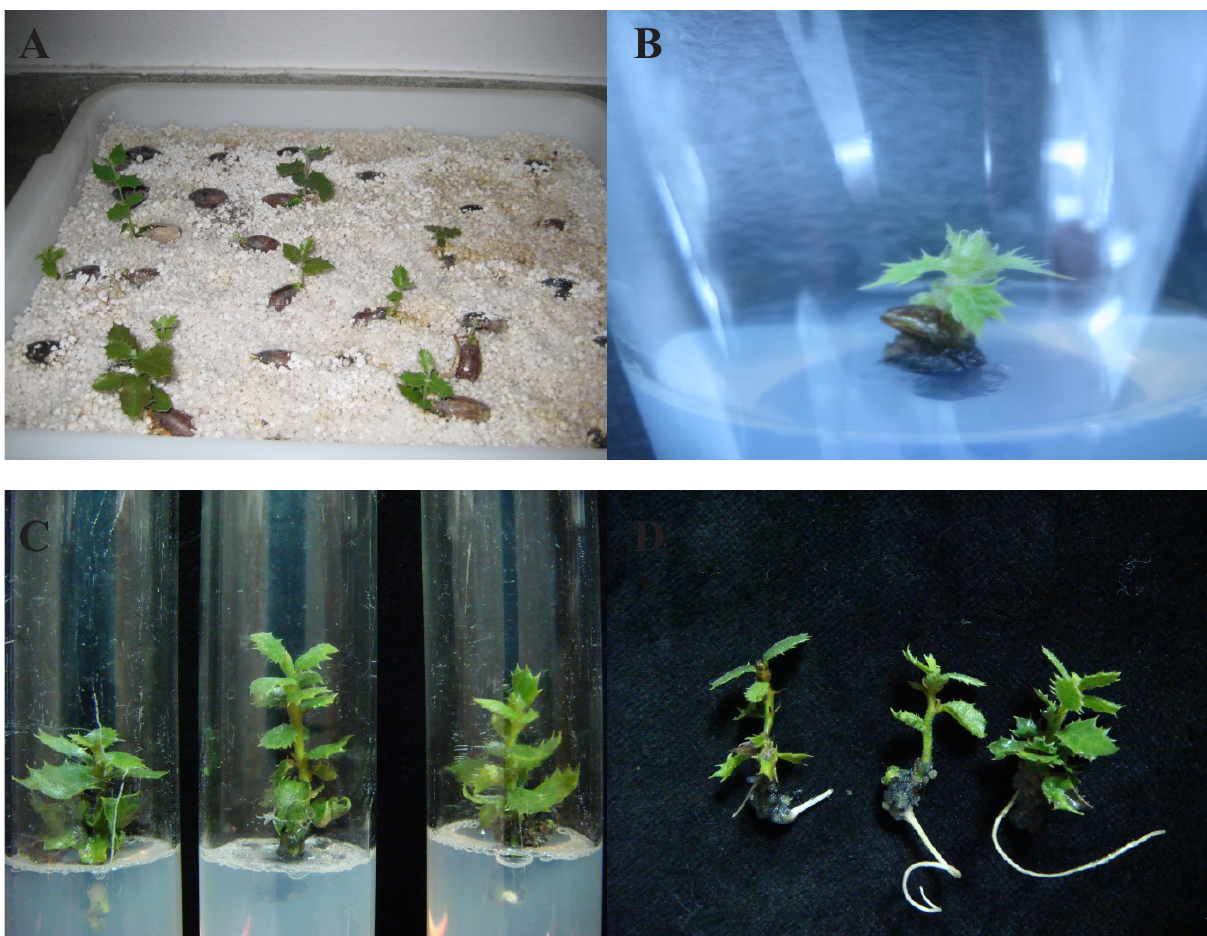
Figure 1. In vitro propagation by axillary shoot proliferation of Quercus ilex . A: Acorns germinated in the growth chamber. B: Shoot development from nodal explants taken from a shoot obtained after acorn germination. C: Appearance of proliferated shoots after 6-week standard multiplication cycle. D: Root development on shoots treated